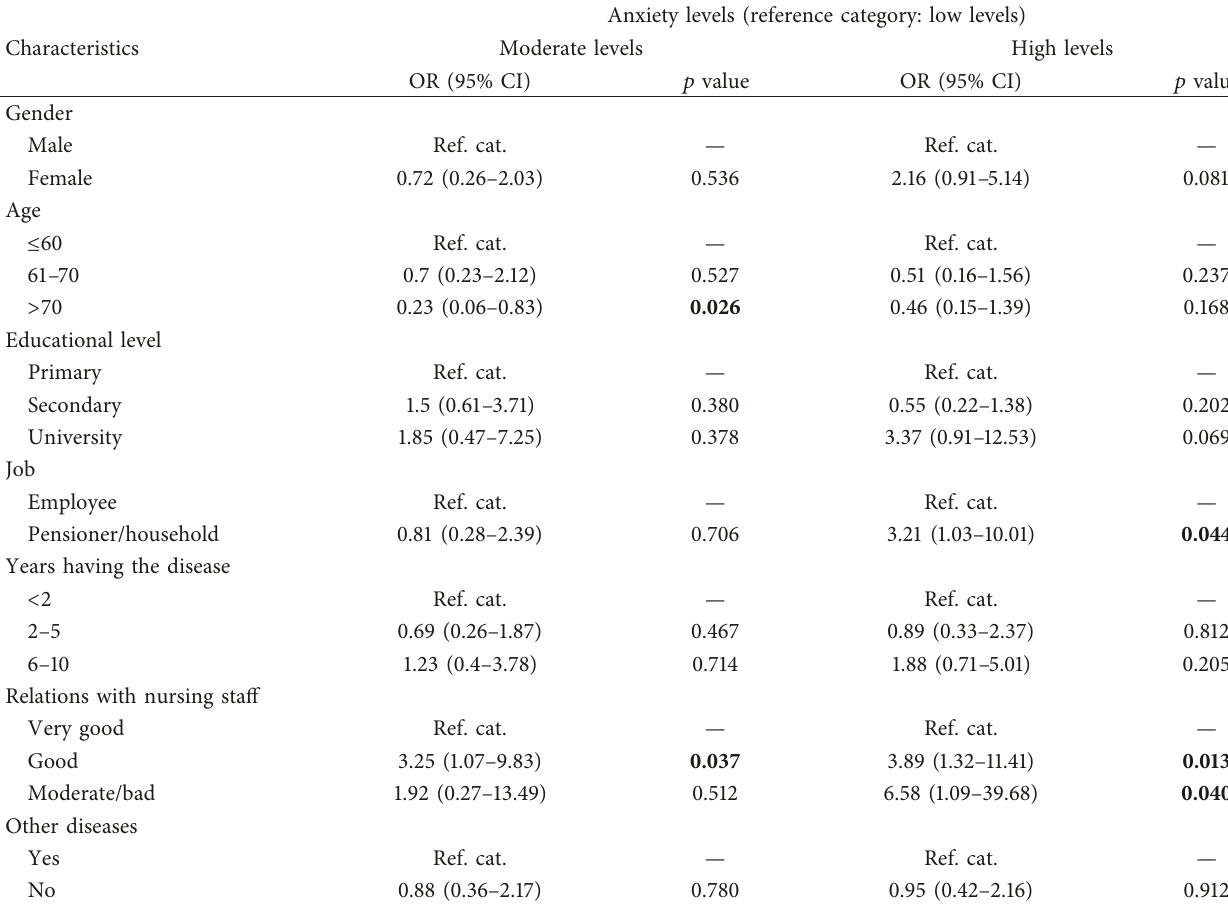
Table 5: Effect of patients’ characteristics on the levels of